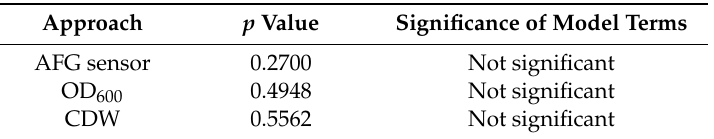
Figure 6. The µ max of B. coagulans in LA batch fermentation mode, with different mechanical energy inputs, determined using the AFG sensor and offline methods. CFV: high level (+) = 1.5 m·s − 1 , low level ( − ) = 0.5 m·s − 1 . TMP: high level (+) = 1.2 bar, low level ( − ) = 0.3 bar. Values are means ± standard deviation ( n = 3). Table 2. The effect of mechanical energy input on cell growth, measured using different approaches. Statistical significance was determined by ANOVA.